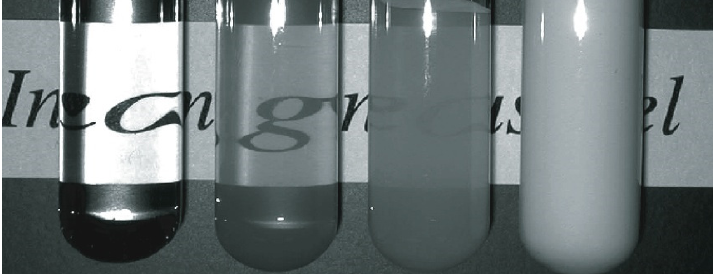
Figure 1. The appearance of the opaque poly(acrylamide) gels. The mole fraction of the cross-linker is 0.01, 0.03, 0.05 and 0.1 from left to right. The total concentration of the pre-gel solution is fixed at 700